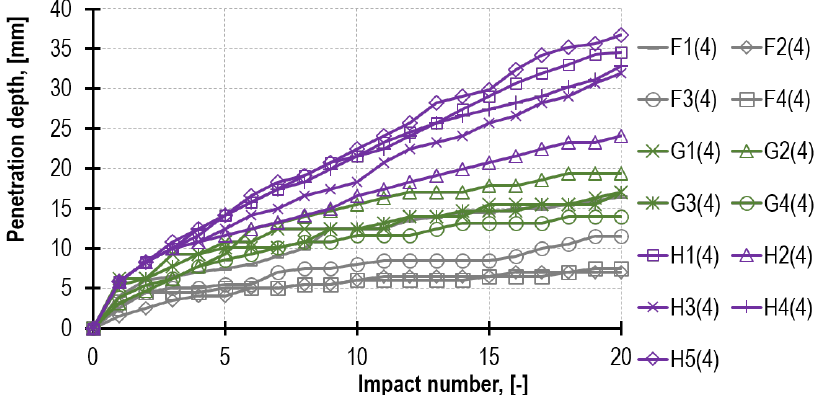
Figure 11. The results of the penetrometric tests conducted on the surface layer of mortar F, G and H after 4 weeks of the prisms masoning.